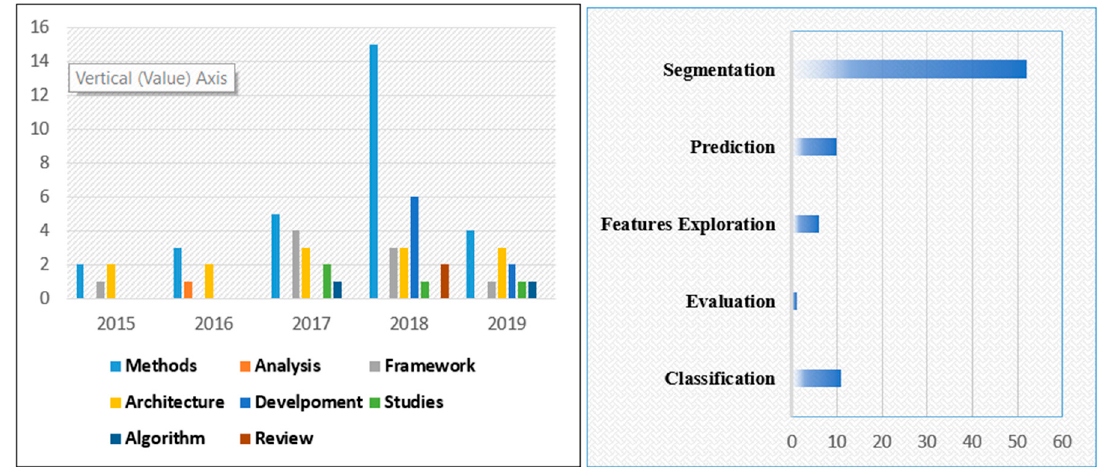
Figure 1. Breakdown of the papers included in this review in the year of publication. 103